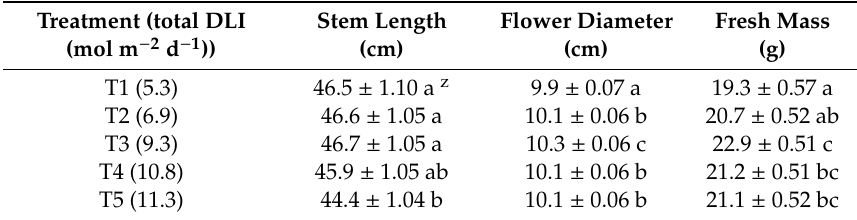
Table 4. Stem length, flower diameter, and fresh mass of ‘Panama’ flowers harvested throughout the trial, for different total daily light integral (DLI) treatments.